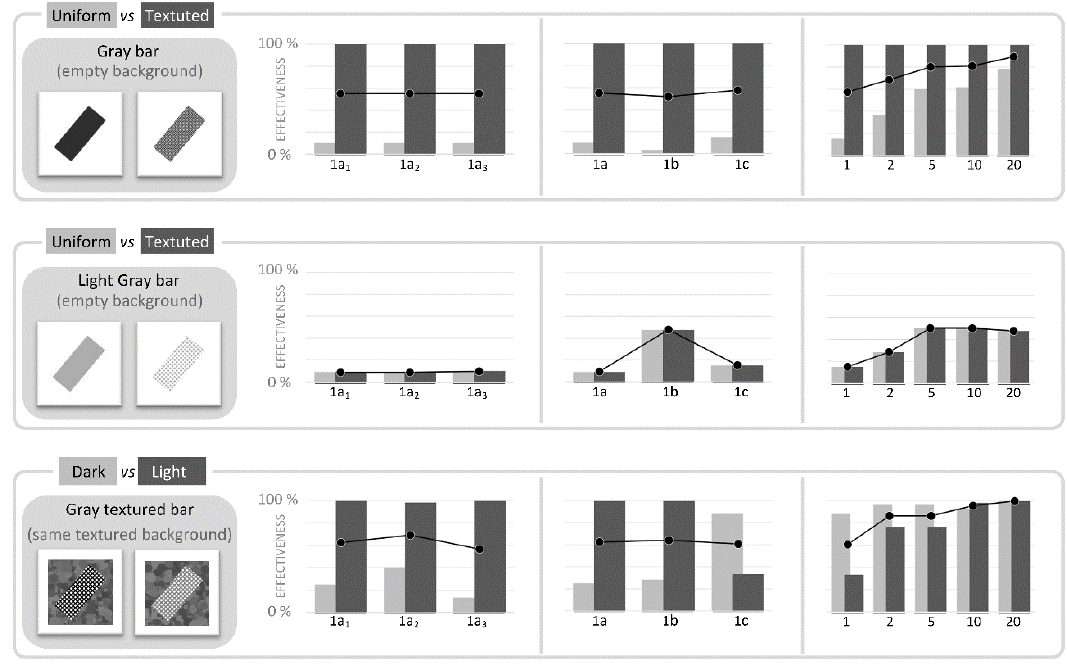
Figure 12. Second set of tests: comparison of performances with different image categories. To assess performances of HMAX in classification, in a second set of tests we compared in pairs different categories of BBID images, analogously to what was done in the pre-test. Thumbnails on the left-hand show a sample each category. Each category was composed by a complete battery of 60 images (10